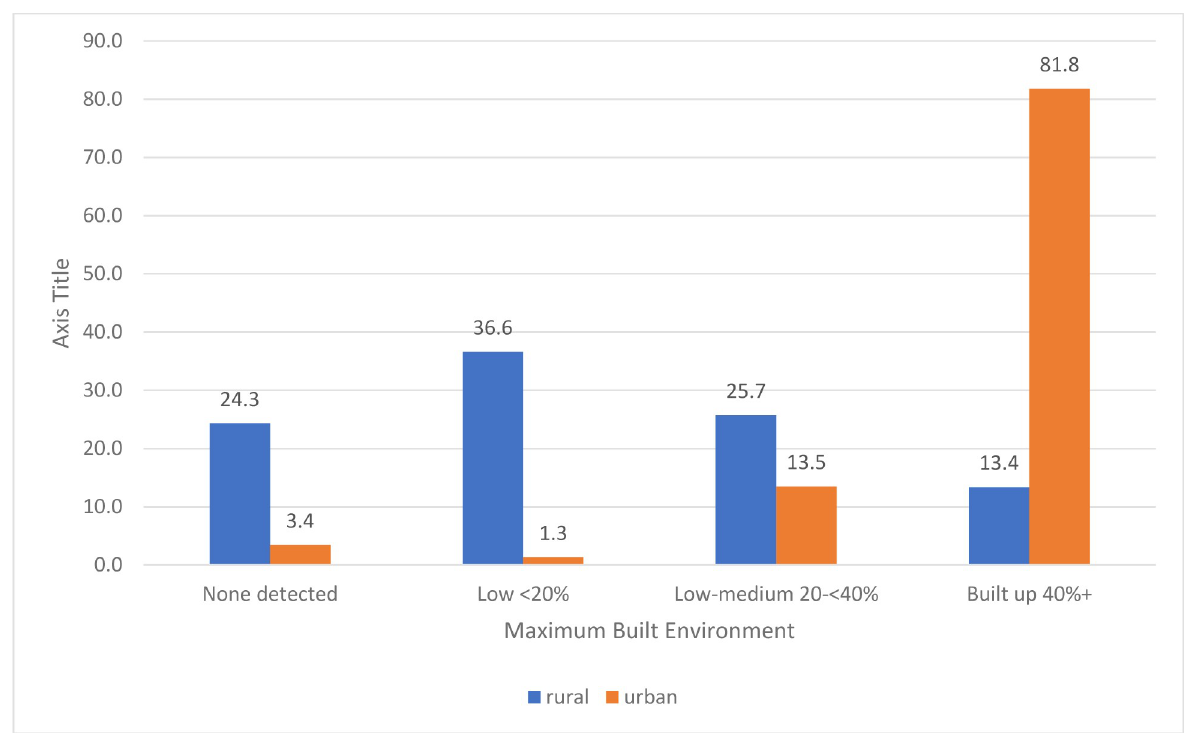
Fig 2. Distribution of the maximum built environment across urban and rural locations.